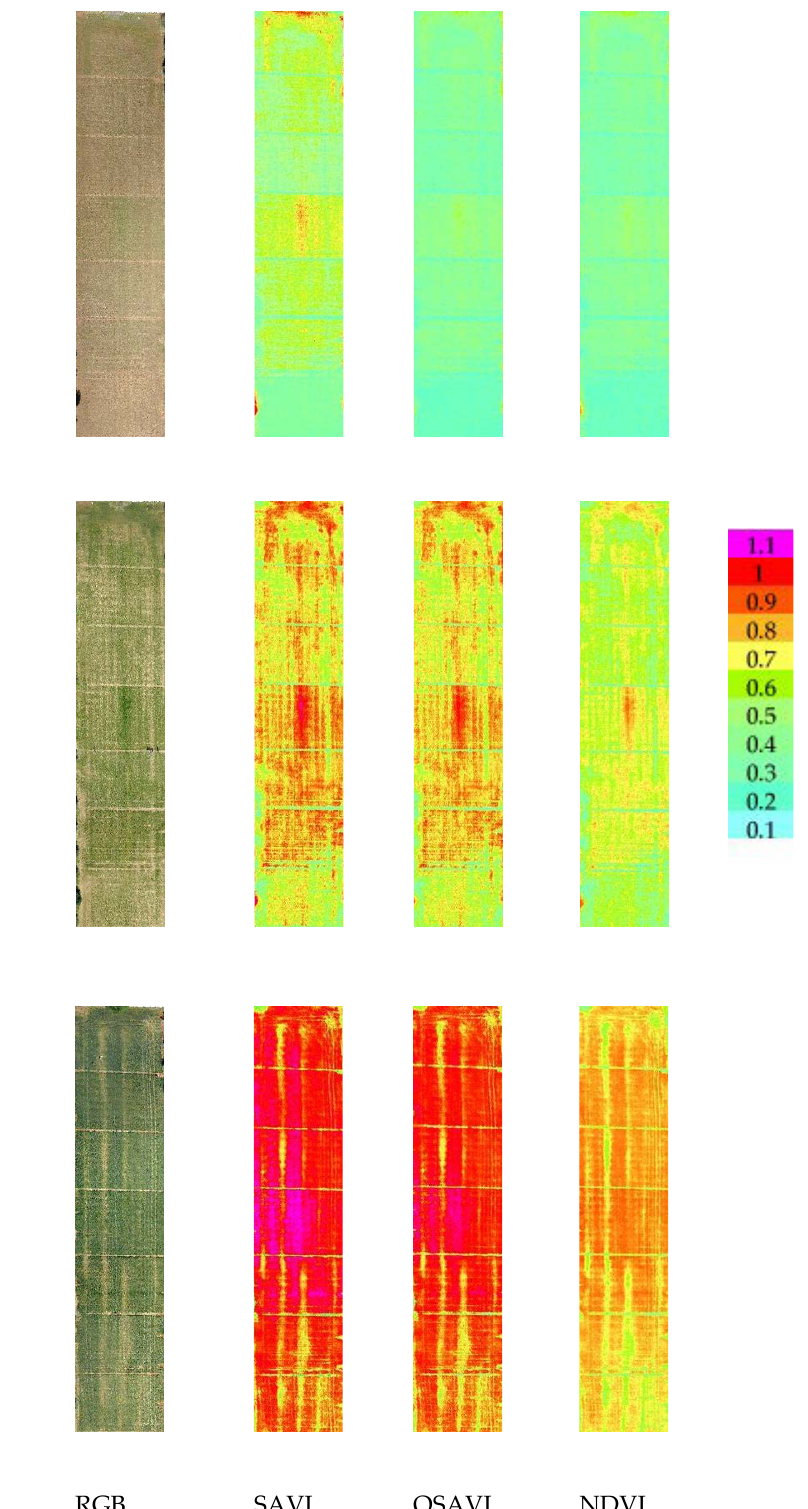
Figure 3. RGB, Soil-Adjusted Vegetation Index (SAVI), Optimized Soil-Adjusted Vegetation Index (OSAVI), and Normalized Difference Vegetation Index (NDVI) maps at different crop stages: seedling, tillering, and flowering growth stage. Maps were elaborated by Pix4D and QGis